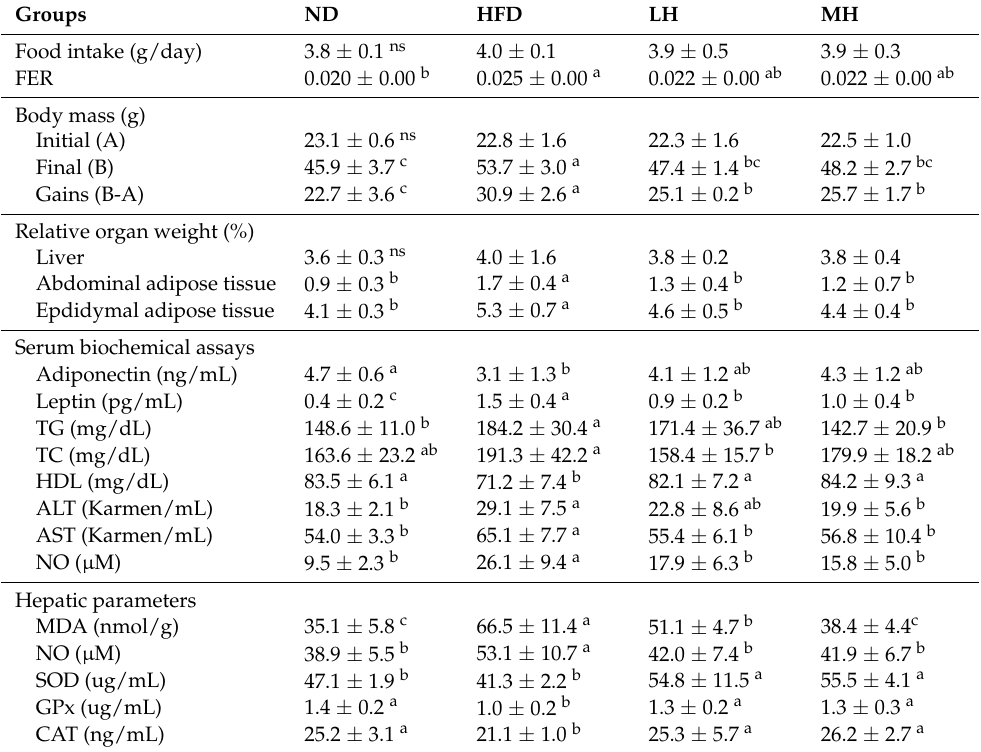
Table 2. Effects on blood and hepatic parameters in HFD-fed mice receiving 6 weeks of treatments.